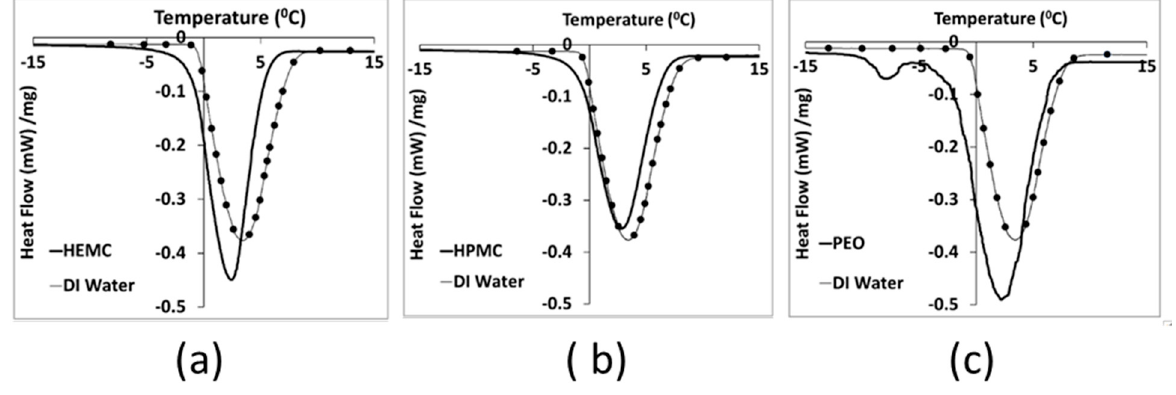
Figure 2. DSC heating curves for: ( a ) Gel 1 (HEMC), ( b ) Gel 2 (HPMC) and ( c ) Gel 3 (PEO), compared to deionized water, i.e., line with dots.